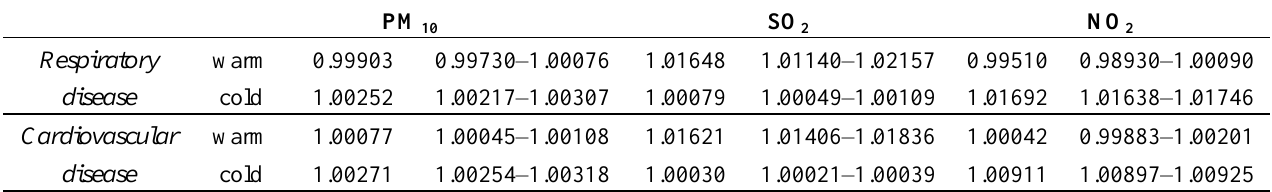
Table 6. RR for a 10 µg/m 3 increase in pollutant levels in seasonal specified